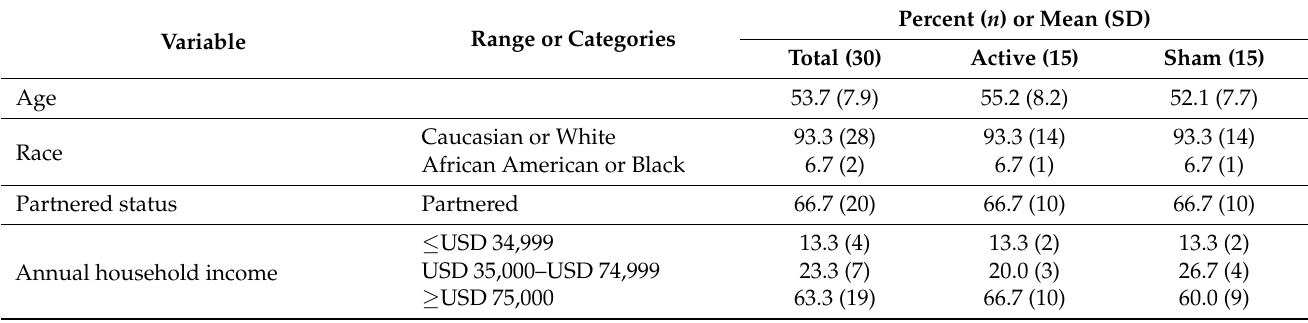
Table 1. Participant characteristics at